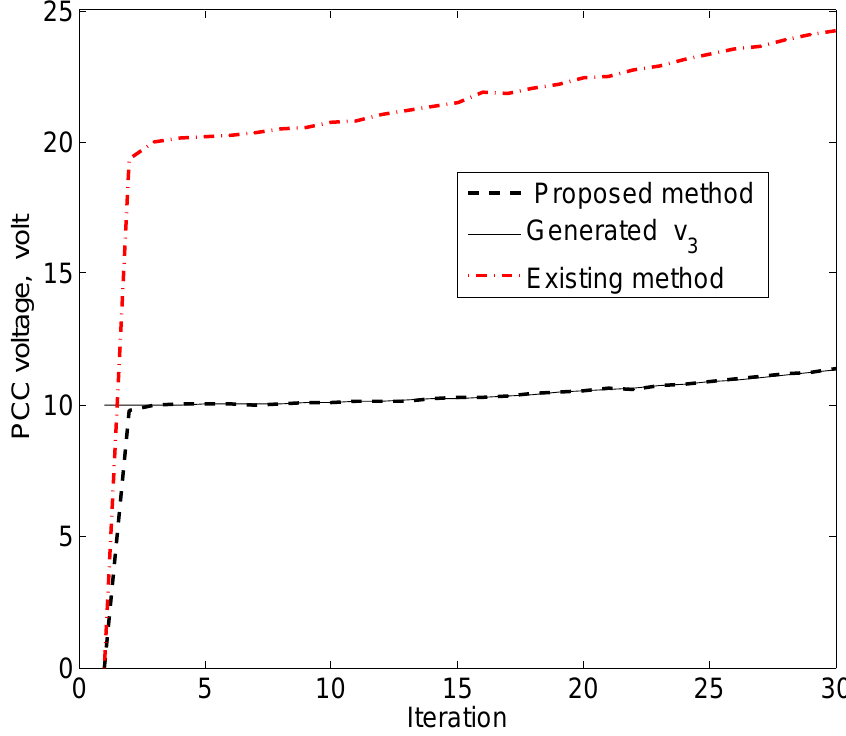
Figure 13. PCC voltage estimation for v